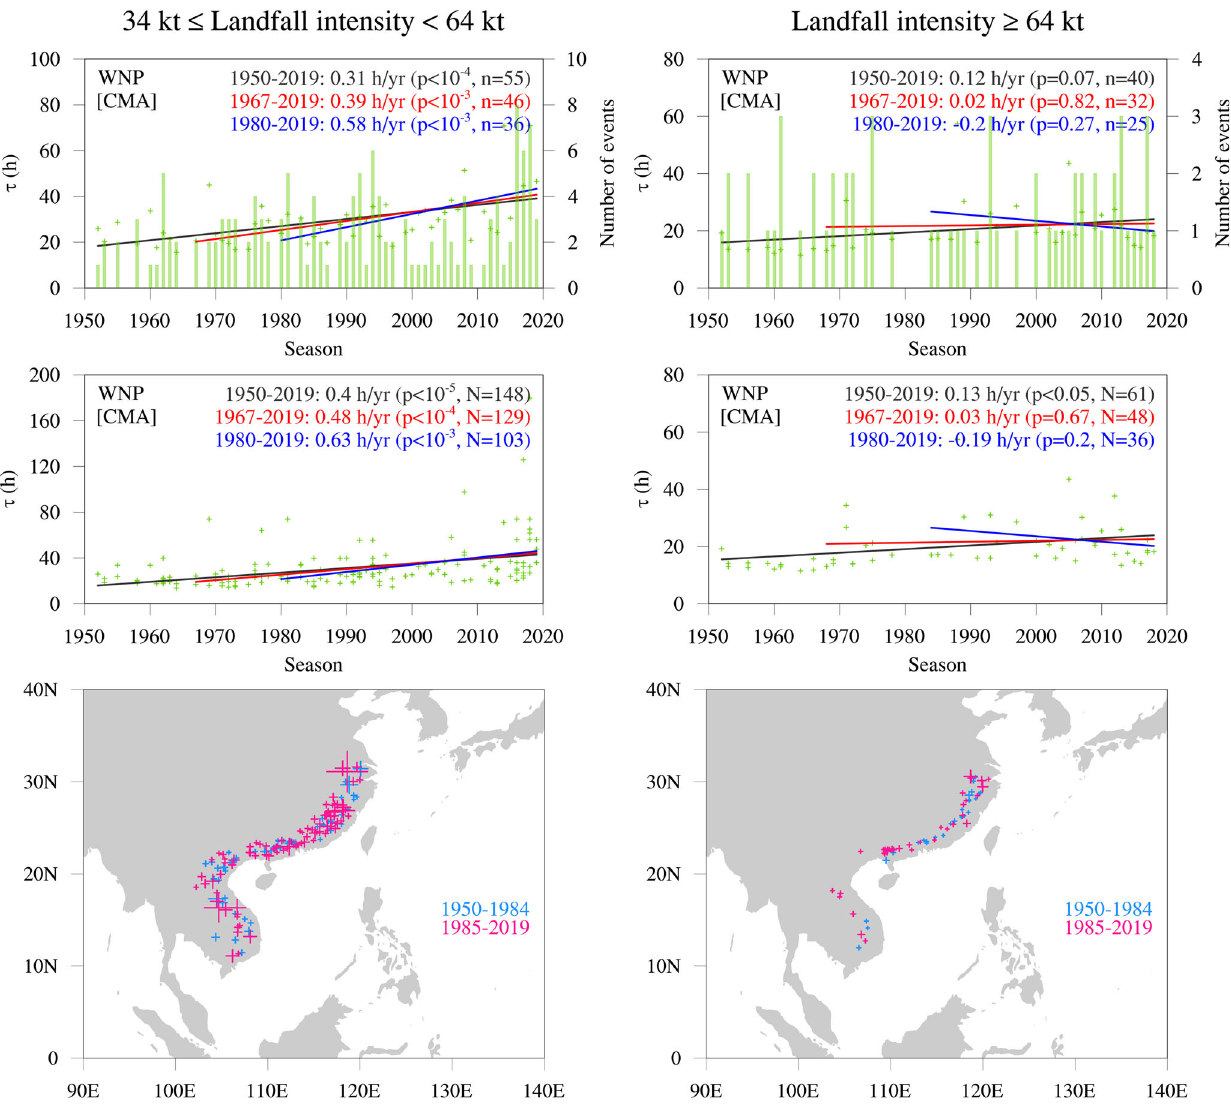
Fig. 4 Global climatology of “ hard-strike ” decay of the western North Paci fi c landfalling tropical cyclones on China and Indochina. Left panels show the results from the weak “ hard-strike ” events with landfall intensity between 34 and 64 kt, while right panels show the results from the strong “ hard-strike ” events with landfall intensity ≥ 64 kt. Top and middle panels show the time series of the season-level τ and event- level τ , respectively. Corresponding linear regression trends over different study periods (lines) and numbers of landfall events (bars) are overlaid. Bottom panels show the spatial distributions of landfall events. Each marker represents the centroid position (the mean of tropical cyclone positions at four synoptic times past landfall) of an event, with its size proportional to the corresponding τ